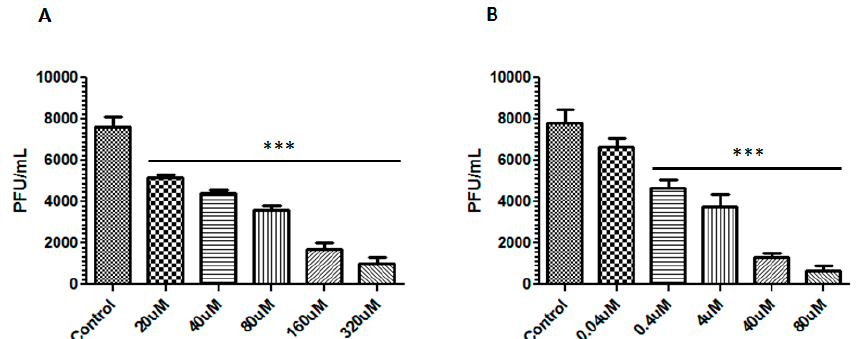
Figure 2. Virucidal assay for berberine and emodin. Different concentrations of berberine ( A ) and emodin ( B ) were incubated with Zika virus (ZIKV) (10 6 PFU/mL) for 1 h. Cells treated with drug diluent was used as control. The results shown are the means (±SD) of three independent events, expressed as relative values compared to the untreated control. *** p <0.0001 vs. control.